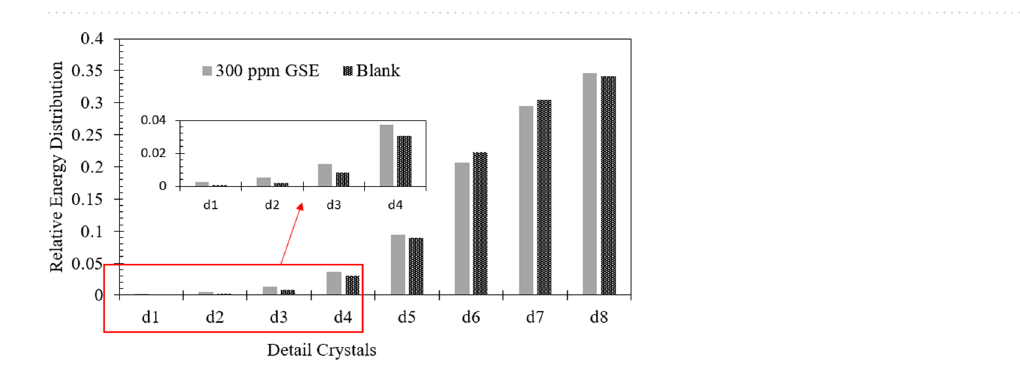
Figure 6. The ECN signals of MS dipped for 3 h in the acid solution containing ( a ) 0 ppm, and ( b ) 300 ppm of GSE.